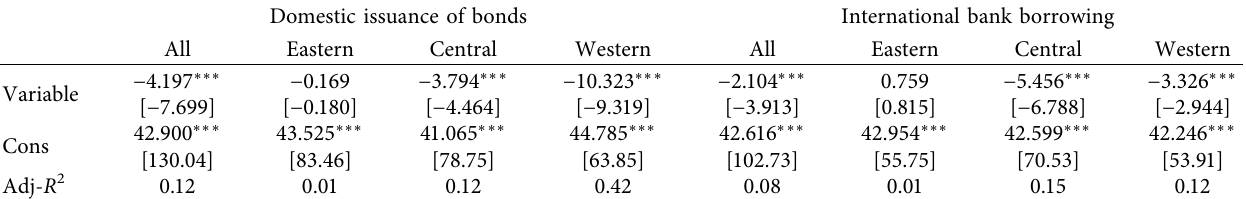
Table 7: Overall fnancing efects of borrowing